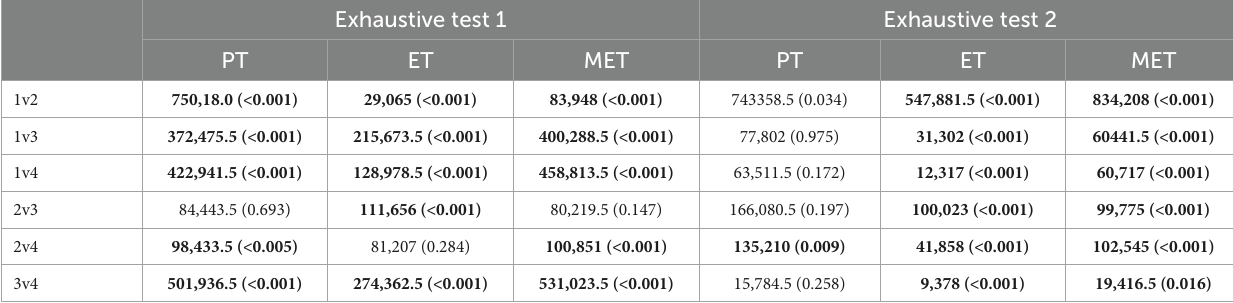
TABLE 7 Wilcoxon signed-rank test results between pair-wised score groups of the two exhaustive